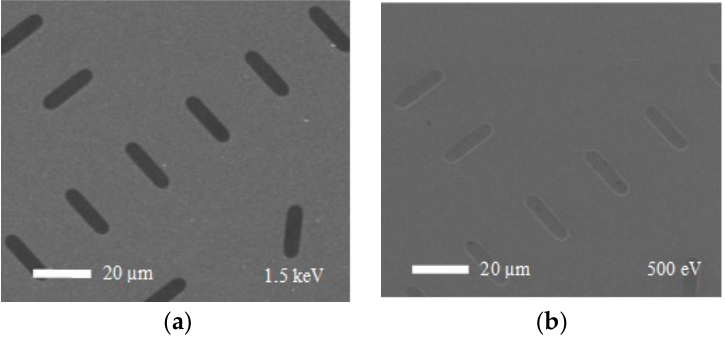
Figure 3. SEM images taken on an identical chip, at different electron beam energies. ( b ) imaged at 500 eV, and ( a ) imaged at 1.5 keV.